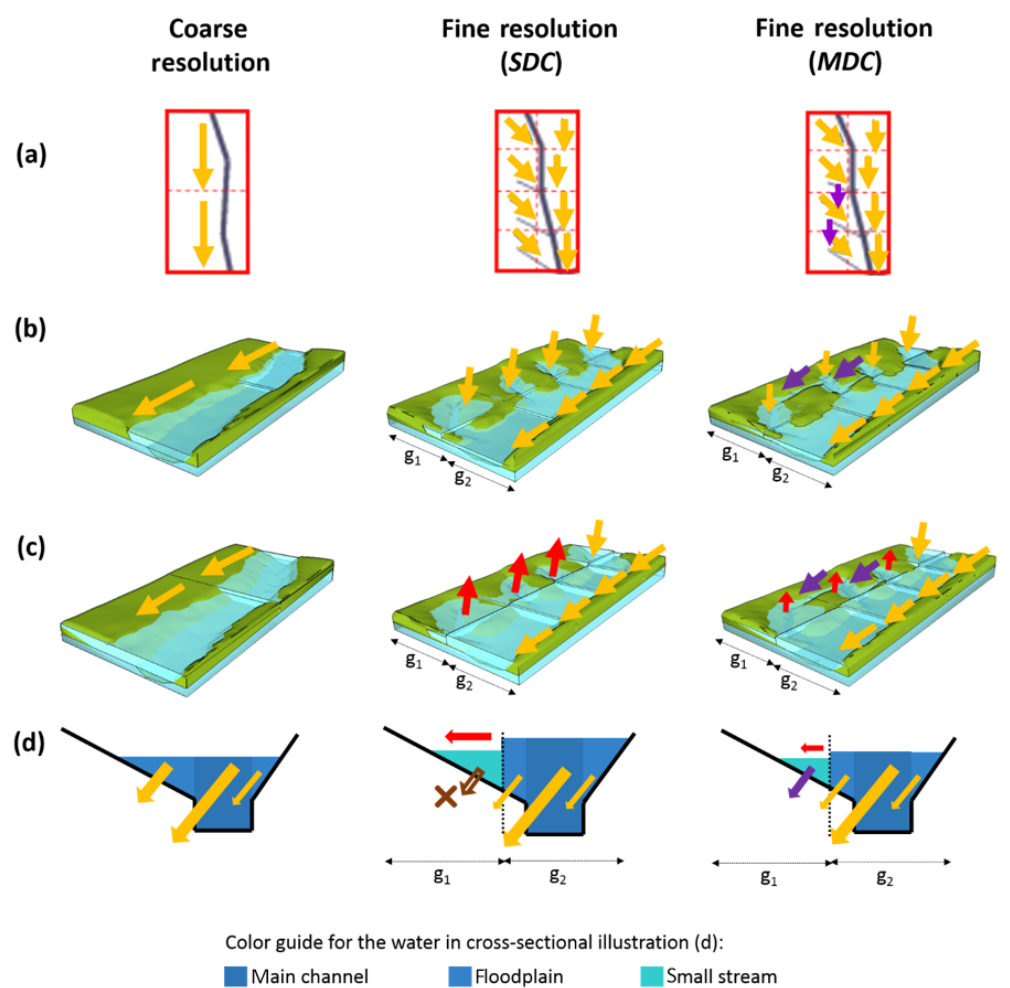
Figure 9. Schematic diagram of the initial distribution of water in coarse and fine resolution simulations. (a) Top view of the river flow network. (b) Isometric 3-D representation of the section of the river. Here, to visualize the small rivers and main channels, vertical features of the floodplain are illustrated with exaggeration. Arrows depict flow direction during non-flood conditions. (c) Isometric and (d) cross- sectional illustration of the flow direction in the river network during flooding. Yellow orange arrows indicate the flow of water to the downstream, purple arrows indicate flow in MDC pathways, red arrows indicate backflows, and brown arrows succeeded by “ × ” marks indicate no flow connectivity in that